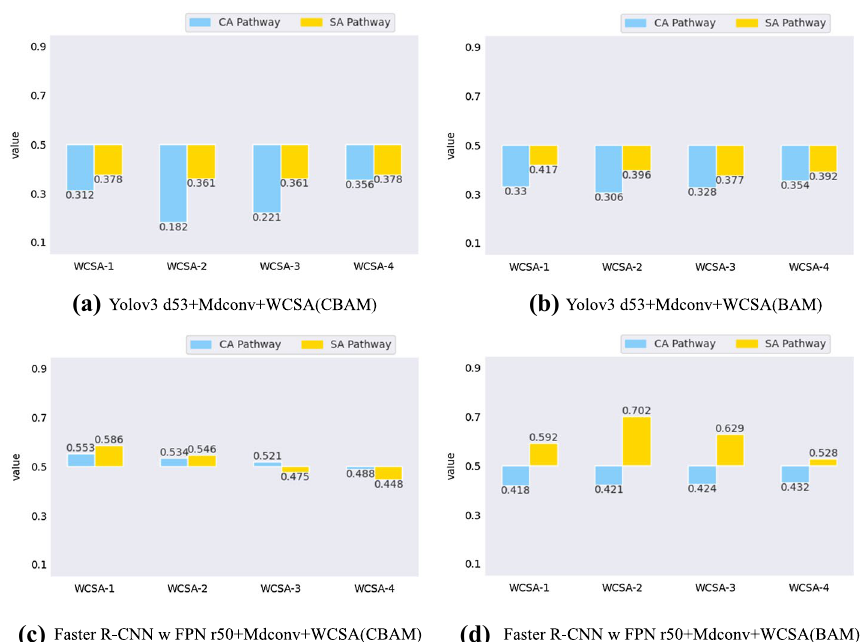
Fig. 7 The changes of pathway-weights. CA: channel attention; SA: spatial attention; d53: DarkNet-53; r50: ResNet-50